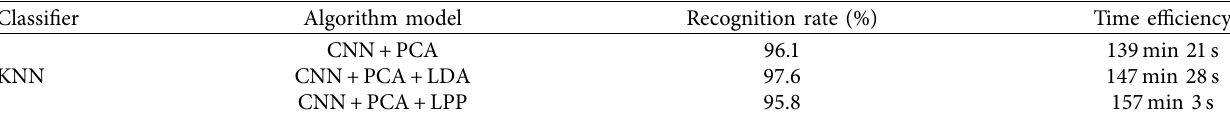
Table 3: Recognition rate and time efficiency of different algorithm models under KNN